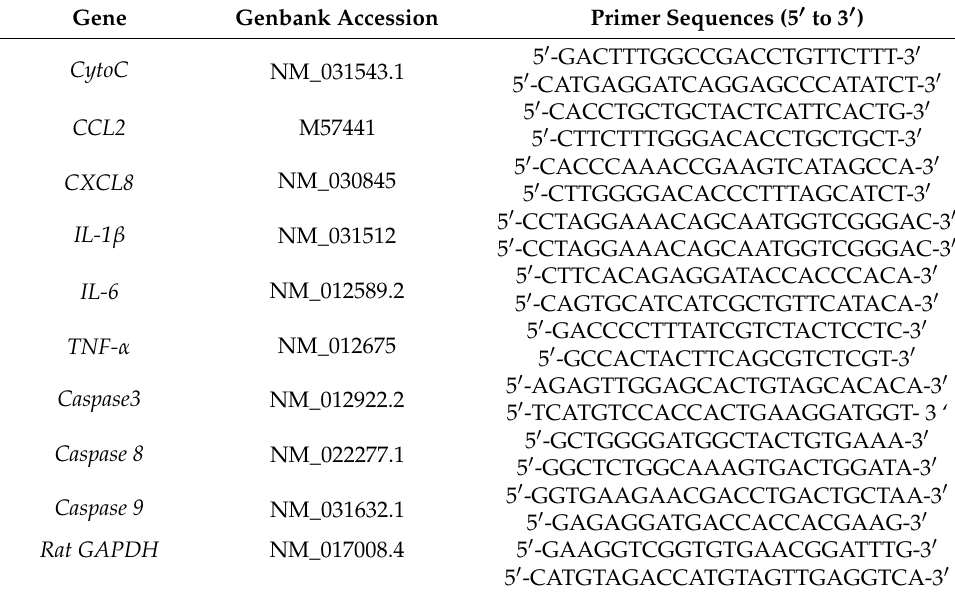
Table 1. Primer sequences for